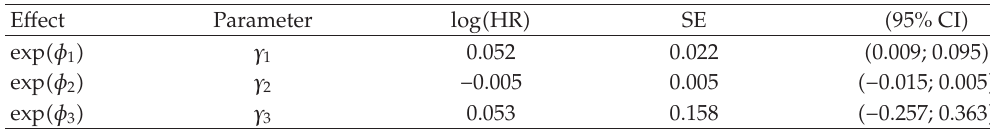
Table 2: Parameter estimates, SE, and 95% confidence/credibility intervals from proportional hazards Cox model for graft survival for plug-in method (cid:6) a (cid:7) , sampled covariates (cid:6) b (cid:7) , and fully Bayesian approach (cid:6) c, d, e (cid:7)